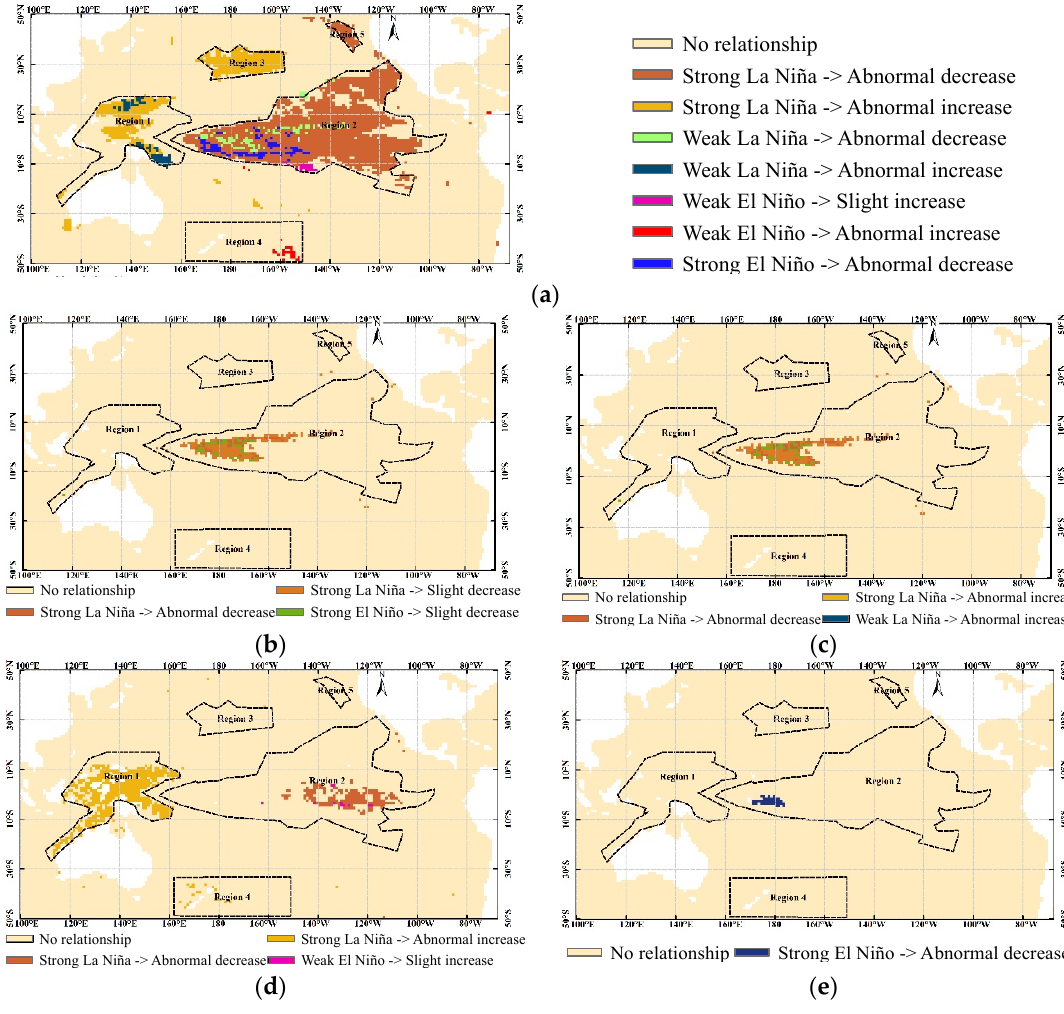
Figure 4. Variations in marine environment caused by ENSO events in PO. ( a ) Association pattern from ENSO to SSTA; ( b ) Association pattern from ENSO to SSPA; ( c ) Association pattern from ENSO to WSA; ( d ) Association pattern from ENSO to SLAA; ( e ) Association pattern from ENSO to CHLA.